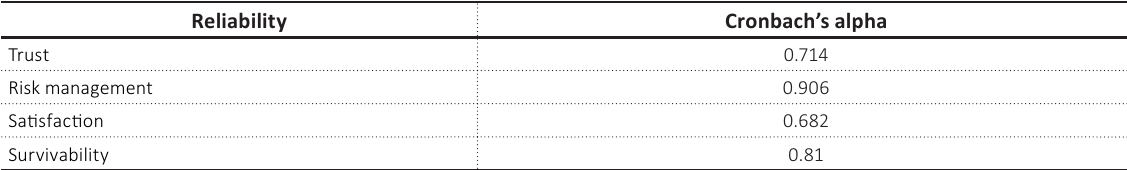
Table 2. Reliability test results